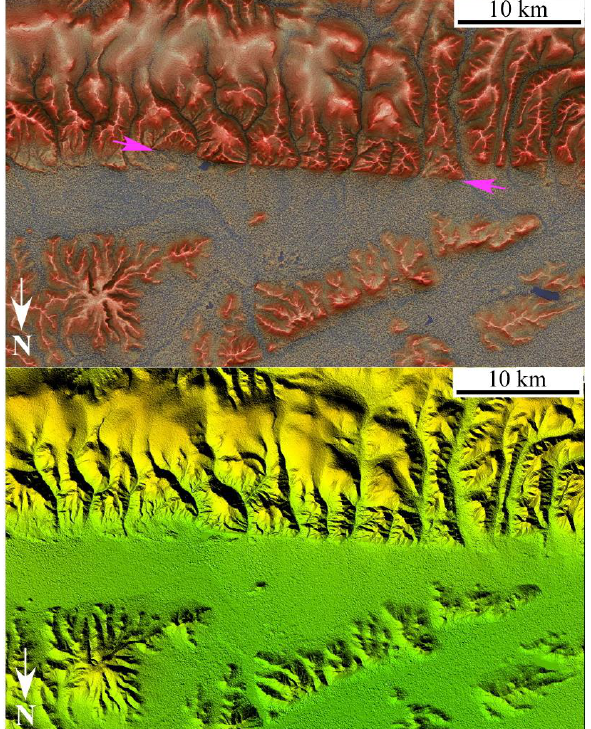
Figure 5. Terminal facet along Bulnay fault. RRIM (upper) and color shaded map (lower)